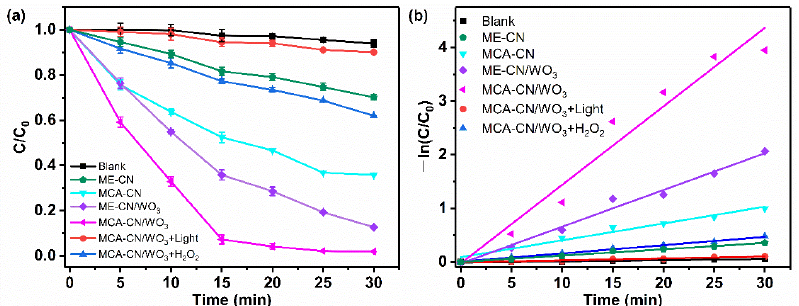
Figure 8. ( a ) Degradation curves of MB under different conditions and ( b ) reaction rate constants associated with MB degradation.